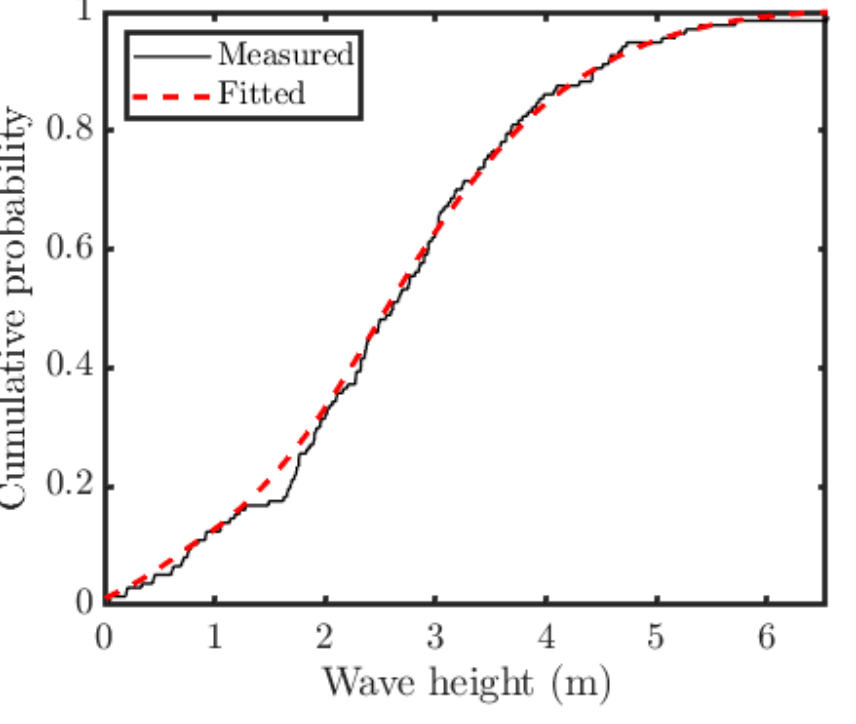
Figure 8. CDF of the measured wave height. Table 1. Prediction conditions derived from the measured waves